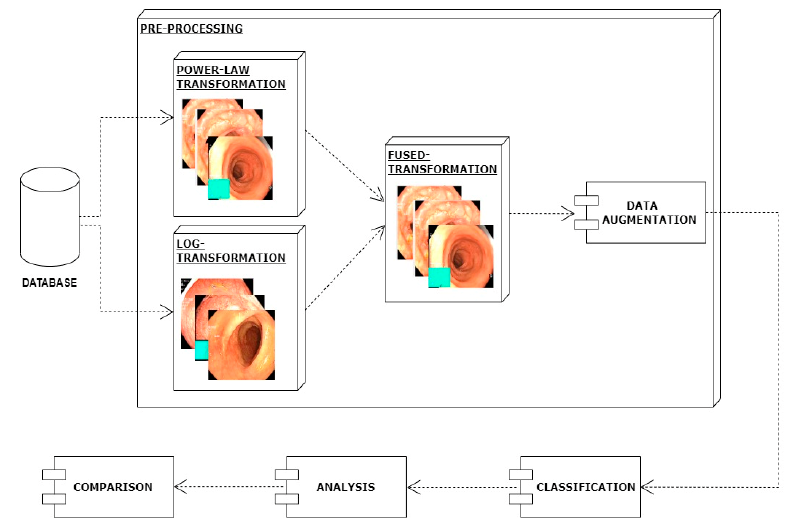
Figure 2. Proposed system architecture.